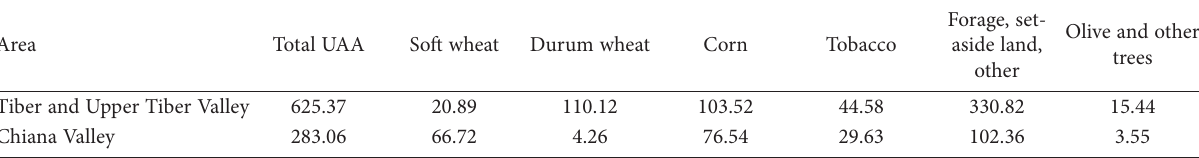
Table 1. Breakdown of UAA (ha) at surveyed farms in the Tiber and Upper Tiber Valleys and the Chiana Valley.